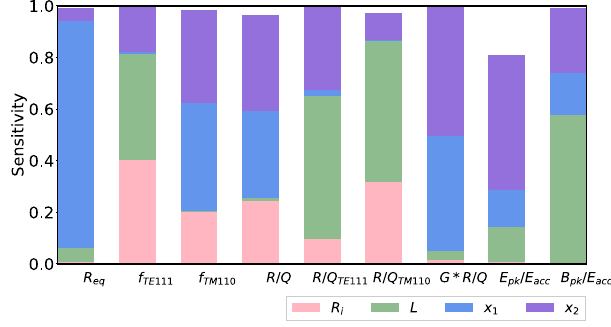
FIG. 15. Main sensitivities. For a point ð R eq ; R i ; L; x 1 ; x 2 Þ [cf. Fig. 12] inside the intervals from Table VII, f to 400.79 MHz using R eq ½ mm (cid:2) ∈ ½ 325 ; 375 (cid:2) . The polynomial degree is p ¼ 2 , so the size of the sample is 45 [cf. Table I].